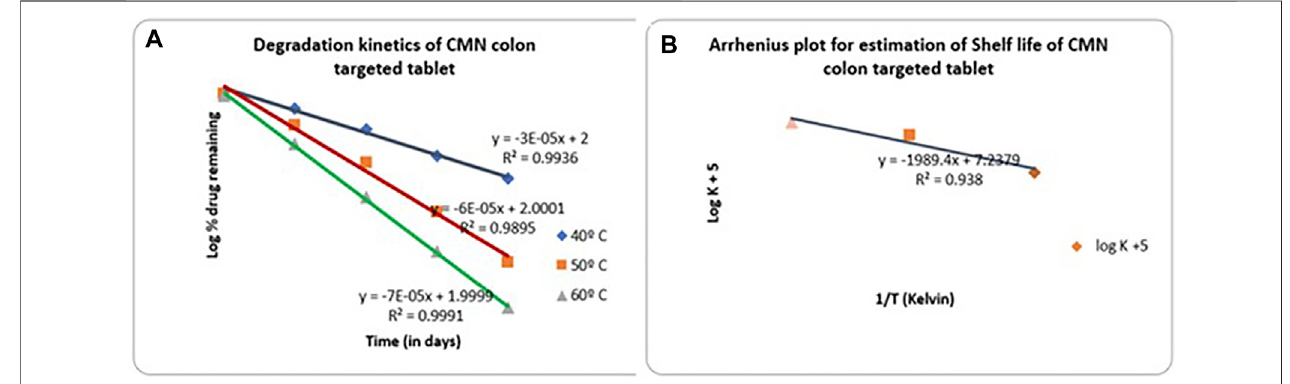
Frontiers in Pharmacology |